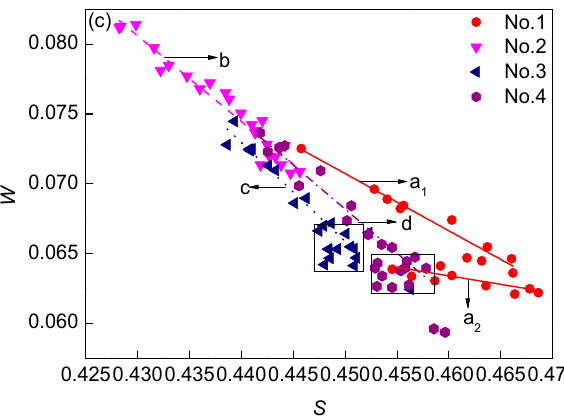
Figure 3. ( a ) S parameters as a function of positron beam energy (and the mean positron injection depth shown on the top X -axis), the scattered dots are the original data and the different lines are the VEPFIT fitting results, ( b ) the fitted S parameter as a function of implanted depth and ( c ) W as a function of S , for CVD-W samples after different neutral beam irradiation conditions.